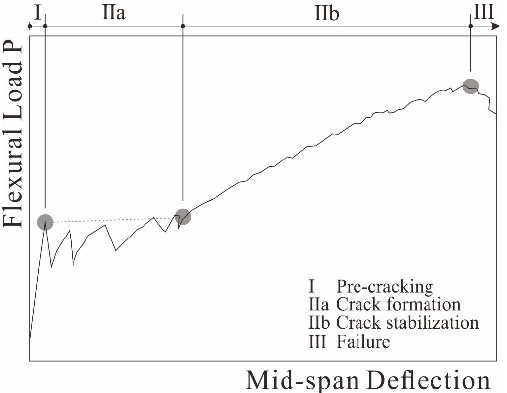
Figure 1. Load–deflection of mid-span relationship for a textile-reinforced concrete (TRC) one-way slab.